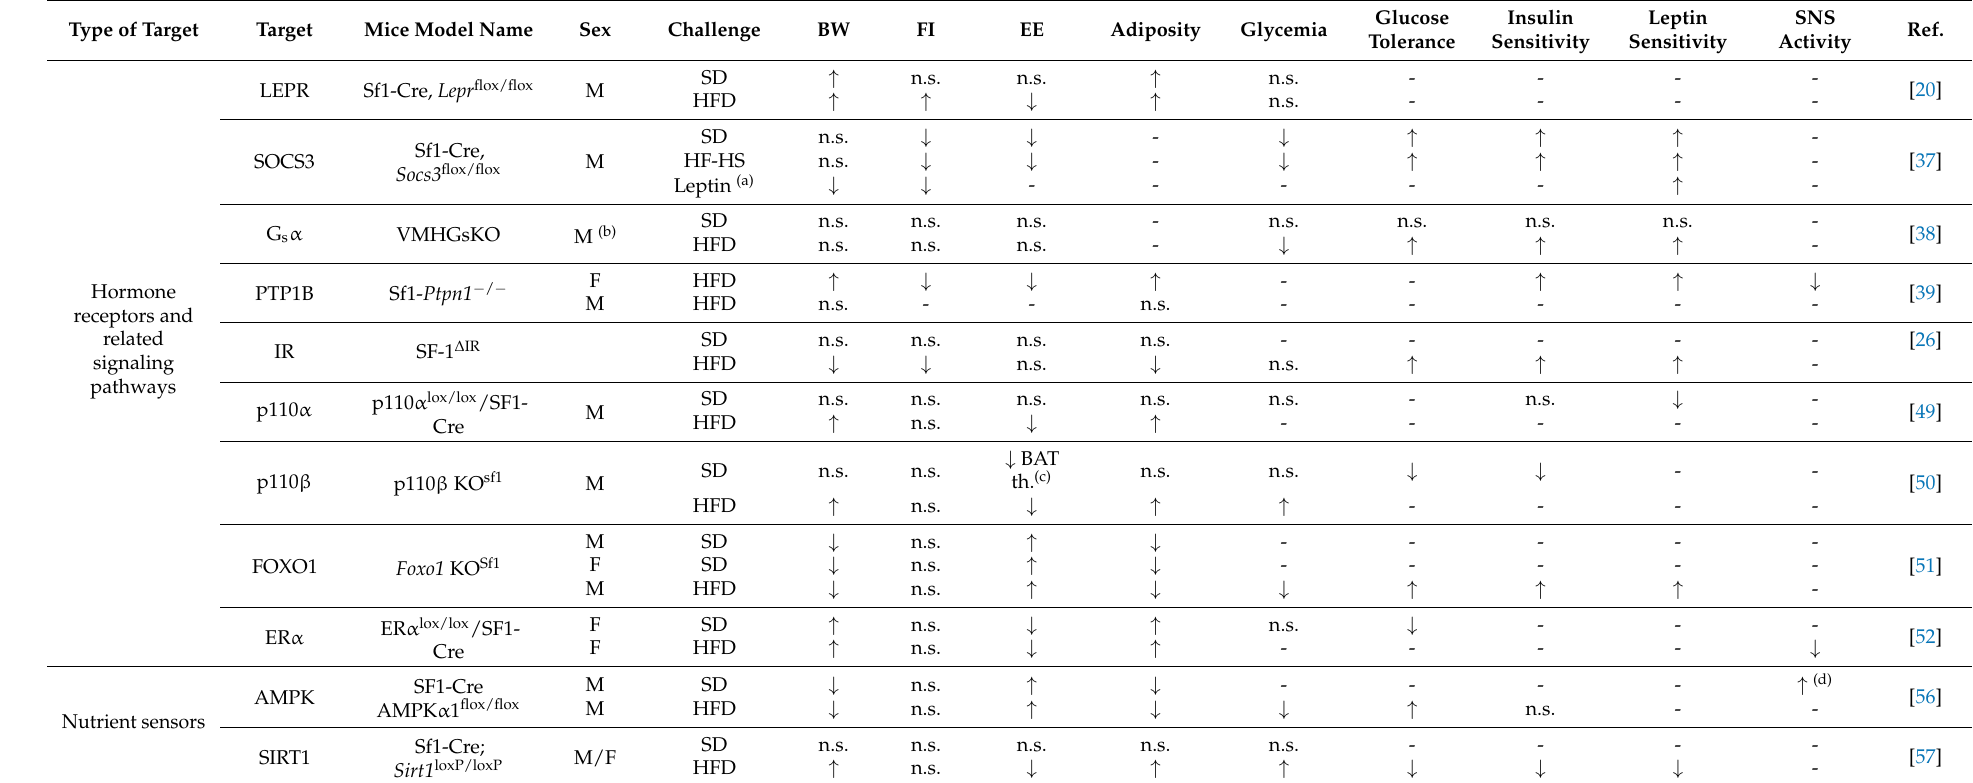
Table 1. Genetic models developed to study SF1 neurons in energy